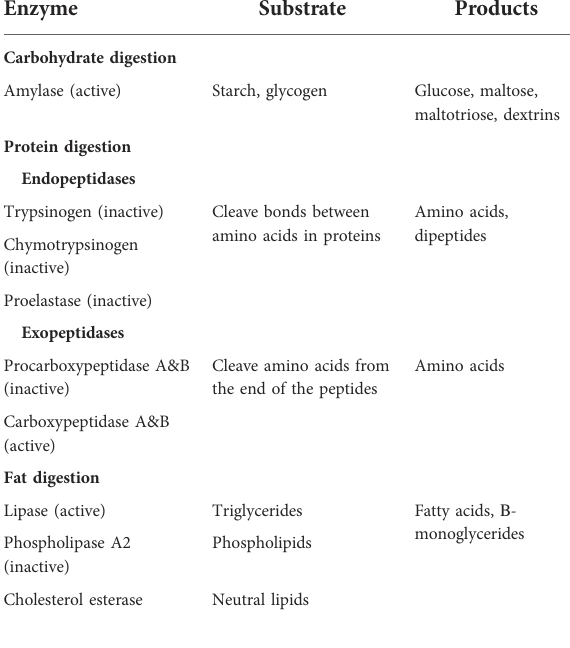
TABLE 1 Summary of the enzymes produced by the acinar cells and their